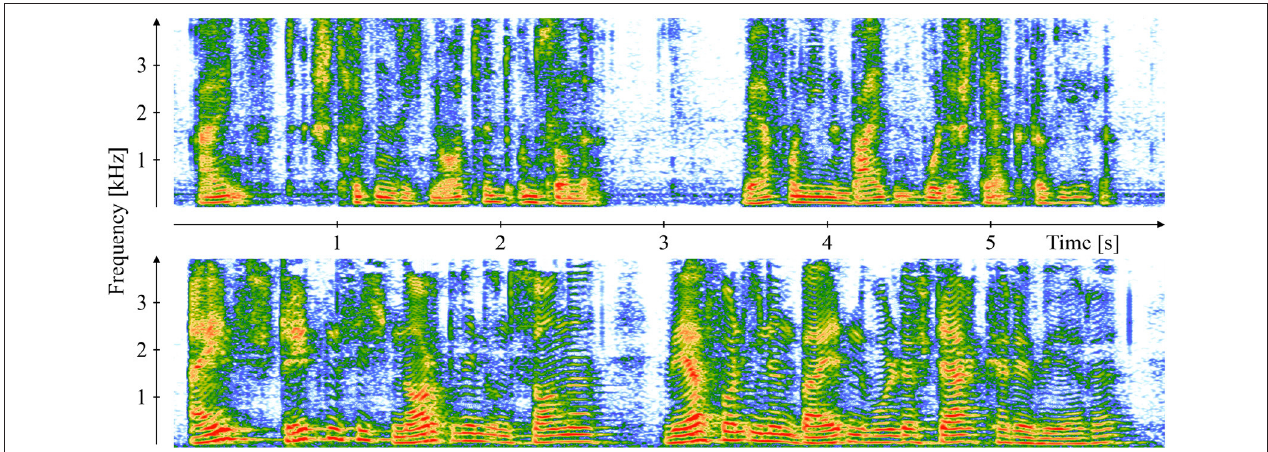
FIGURE 1 | Comparison of a 19-year-old symptomatic male with COVID-19 (top) and a 37-year-old asymptomatic COVID-19 negative male (bottom) by means of speech spectrograms of the recorded first clause of the German standard text “The Northwind and the Sun” [“Einst stritten sich Nordwind und Sonne, wer von ihnen beiden wohl der Stärkere wäre."] . The recordings are part of the “Your Voice Counts” dataset ( 12, 13).